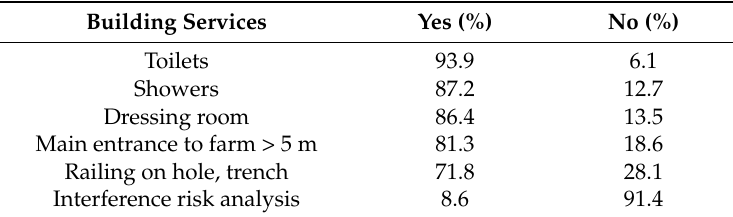
Table 4. Situation of buildings in the farm.